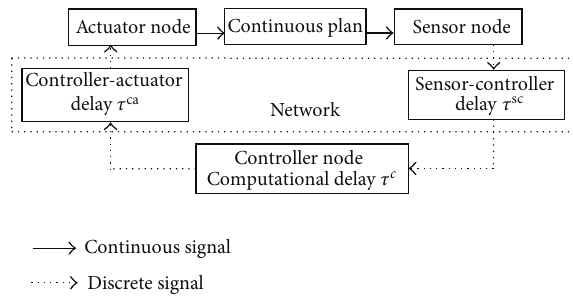
Figure 1: A networked control